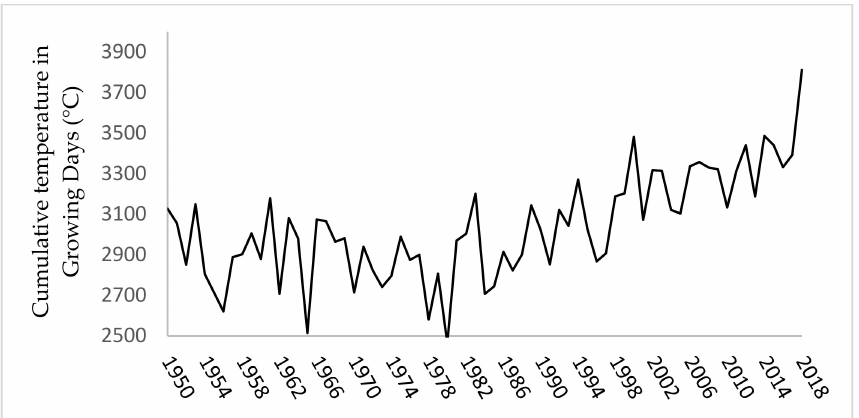
Figure 4. Cumulative temperature in growing degree days (sum of mean daily temperatures on days with T > 4 ◦ C) estimate from E-OBS v.21.e 0.25 ◦ gridded